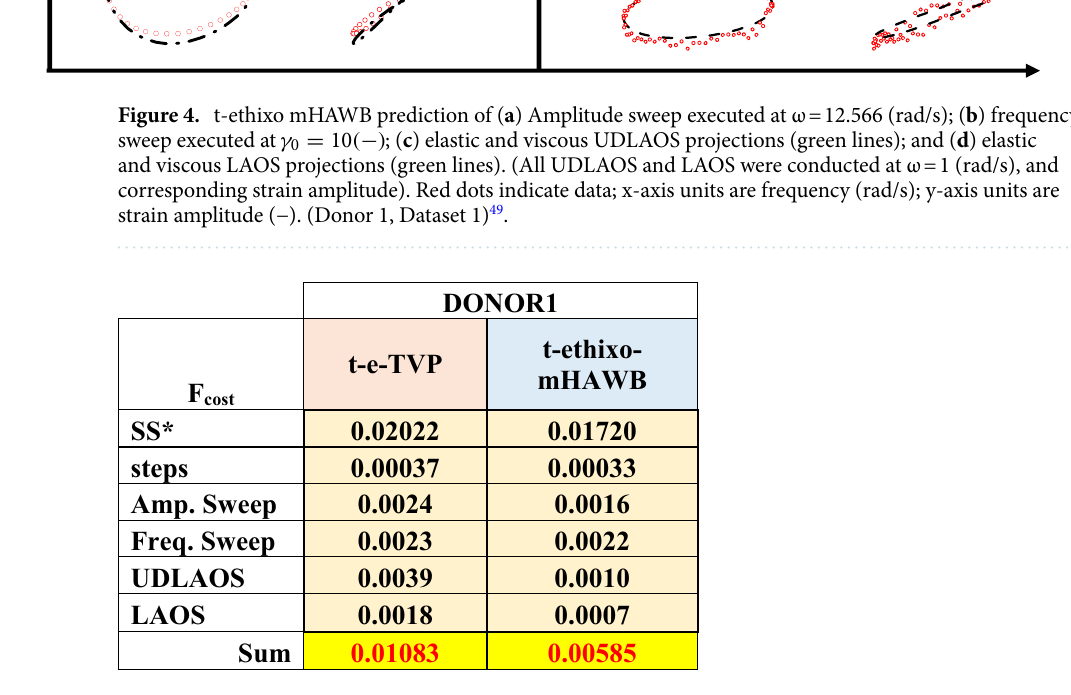
Table 6. F cost comparison for model predictions (Sweeps, LAOS, UDLAOS) over experimental fits (steady state, shear rate step tests; note that steady state is not included because it is nondimensionalized) (Donor